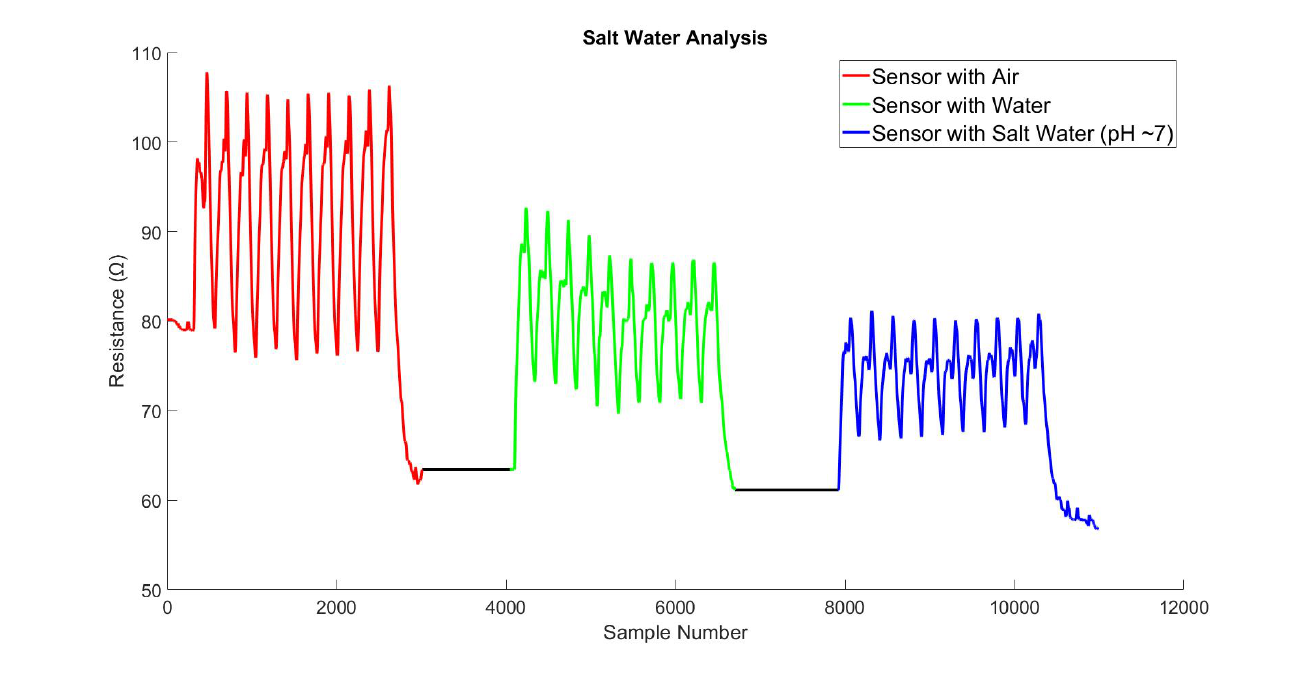
Figure A9. Salt-fog test data of (sensor-4).